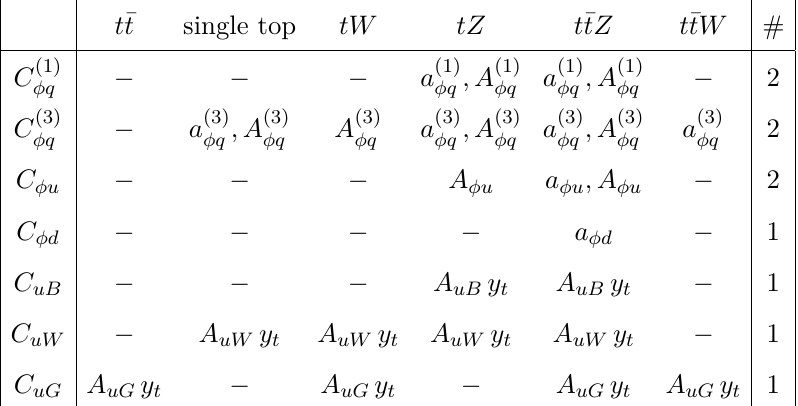
Table 6 . Two-quark operator contributions to top-quark production in MFV. Shown are the flavor structures for all SMEFT contributions that interfere with the SM amplitude at LO QCD ( t ¯ t , t ¯ tZ , t ¯ tW ) and at LO EW (single top, tW , tZ ). Contributions to observables of O ( y 2 CKM-suppressed contributions are neglected. In the last column we count the number of flavor degrees of freedom that can be